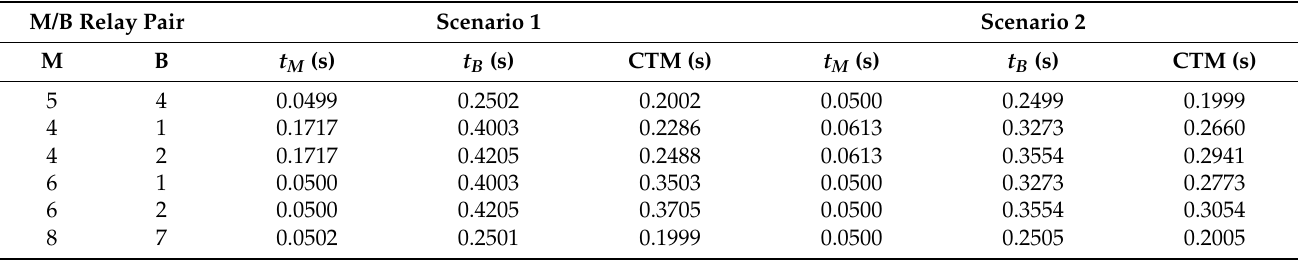
Table 11. Operating times of M/B relay pairs of the Agiba Network using Test Model